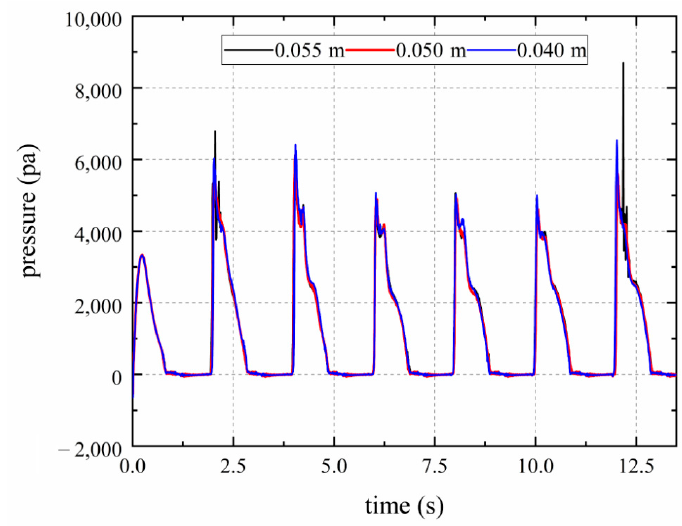
Figure 9. The pressure of K2 point with three foundation mesh sizes.